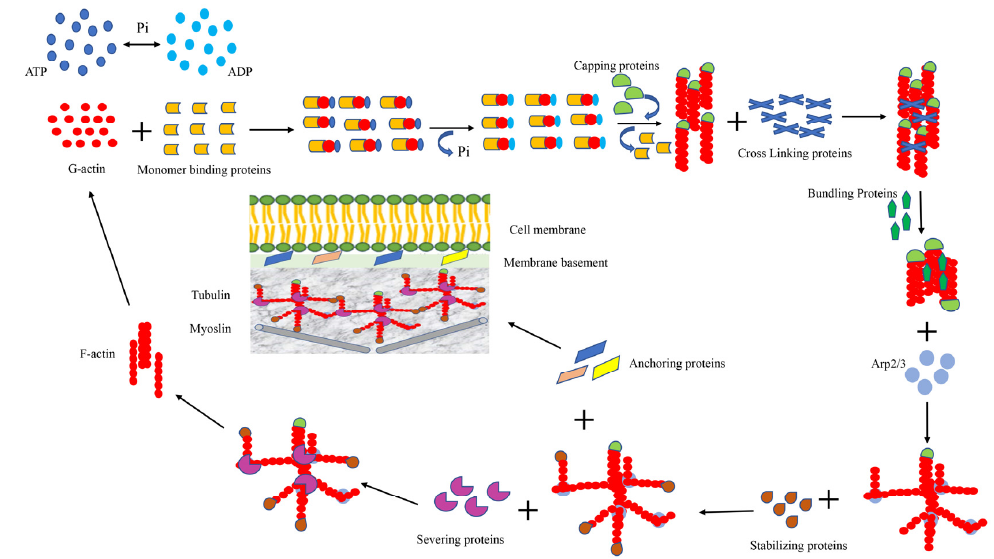
Figure 1. Actin-binding proteins. This figure shows the proteins involved in actin binding, capping, cross-linking, bundling, severing and